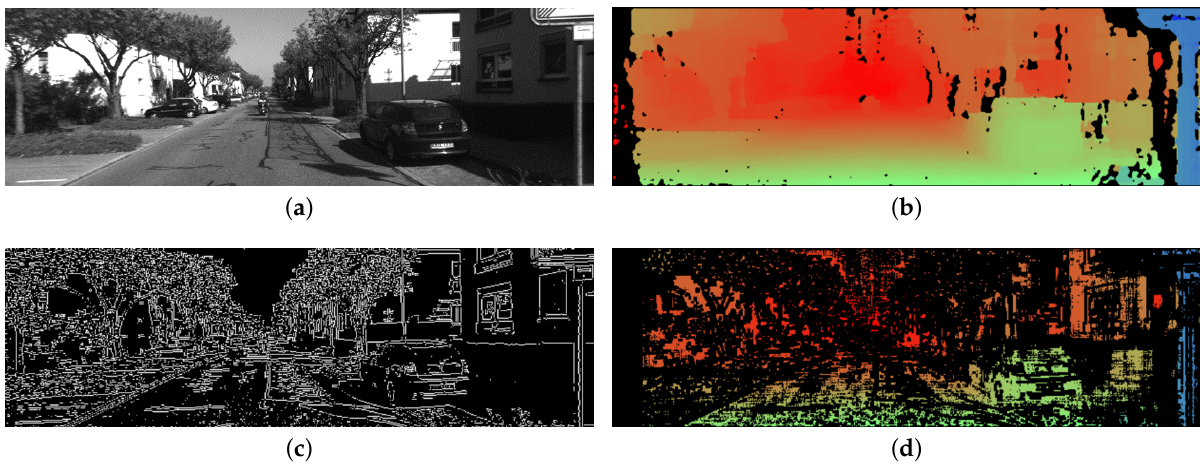
Figure 2. The disparity image is transformed from grey image to color image for visualization. The value of disparity is normalized and used as hue channel value of HSV ((Hue, Saturation, Value) color space. The pixel which is black means the disparity is unknown. The edge image is captured from the left image. The white pixels show the edge area. ( a ) Image from KITTI dataset [16] sequence 00 (left camera). ( b ) Disparity image. ( c ) Edge image. ( d ) Disparity image applied